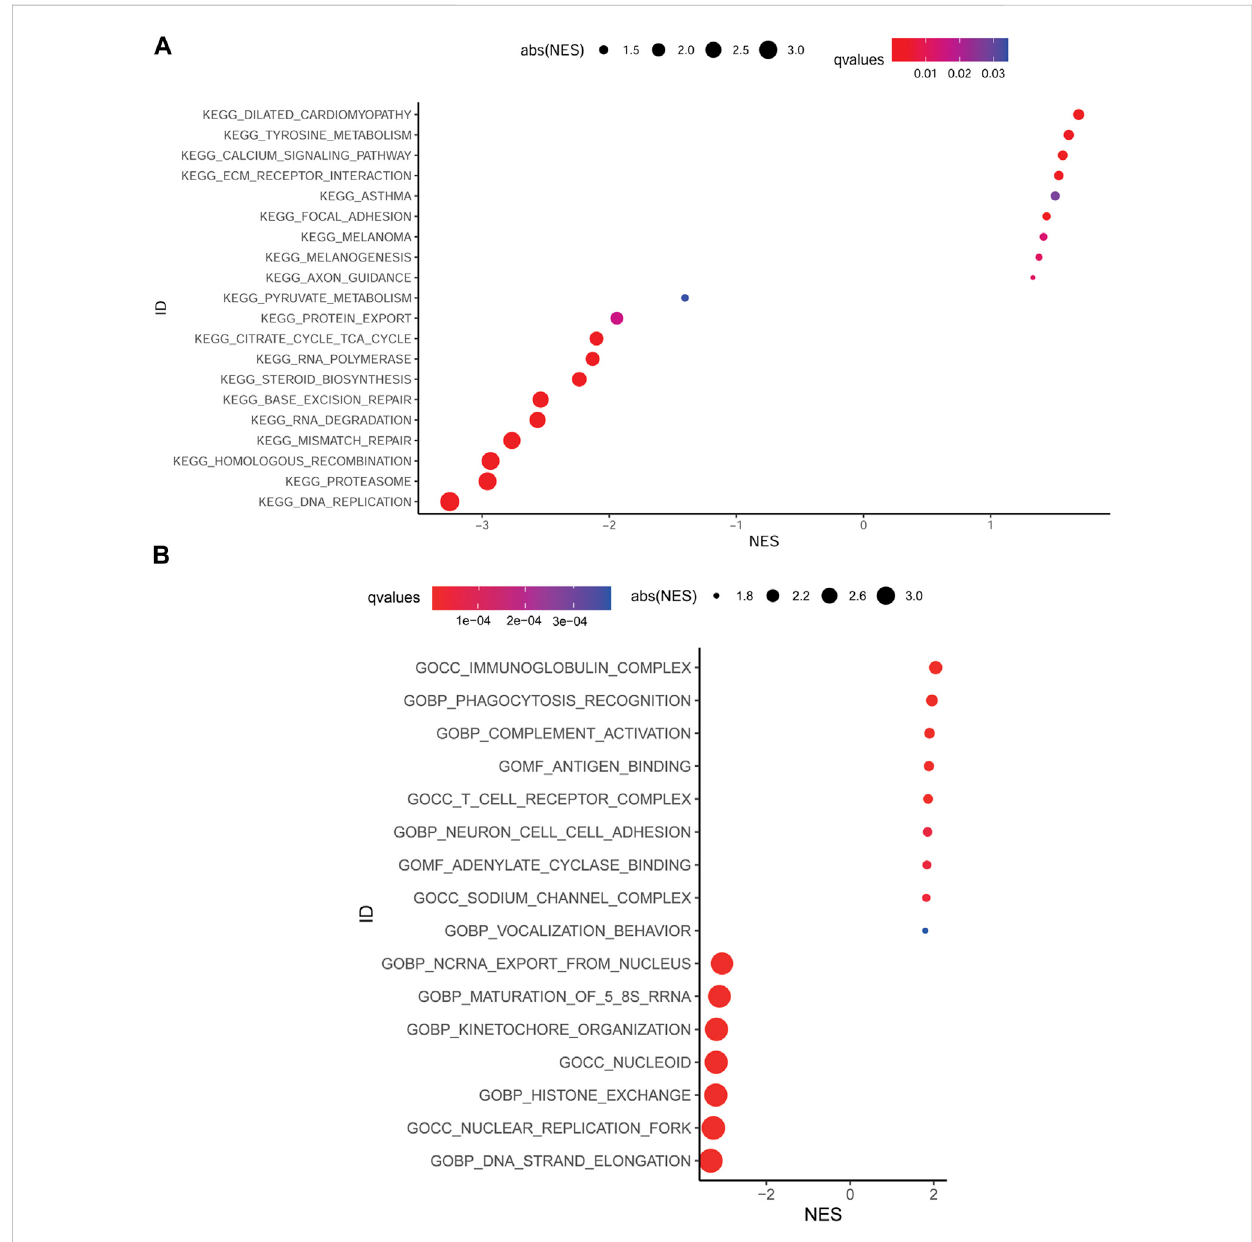
applied the logistic binary regression analysis. As shown in Figure 6D, we found that the high MMP score group tends to have fewer mutation